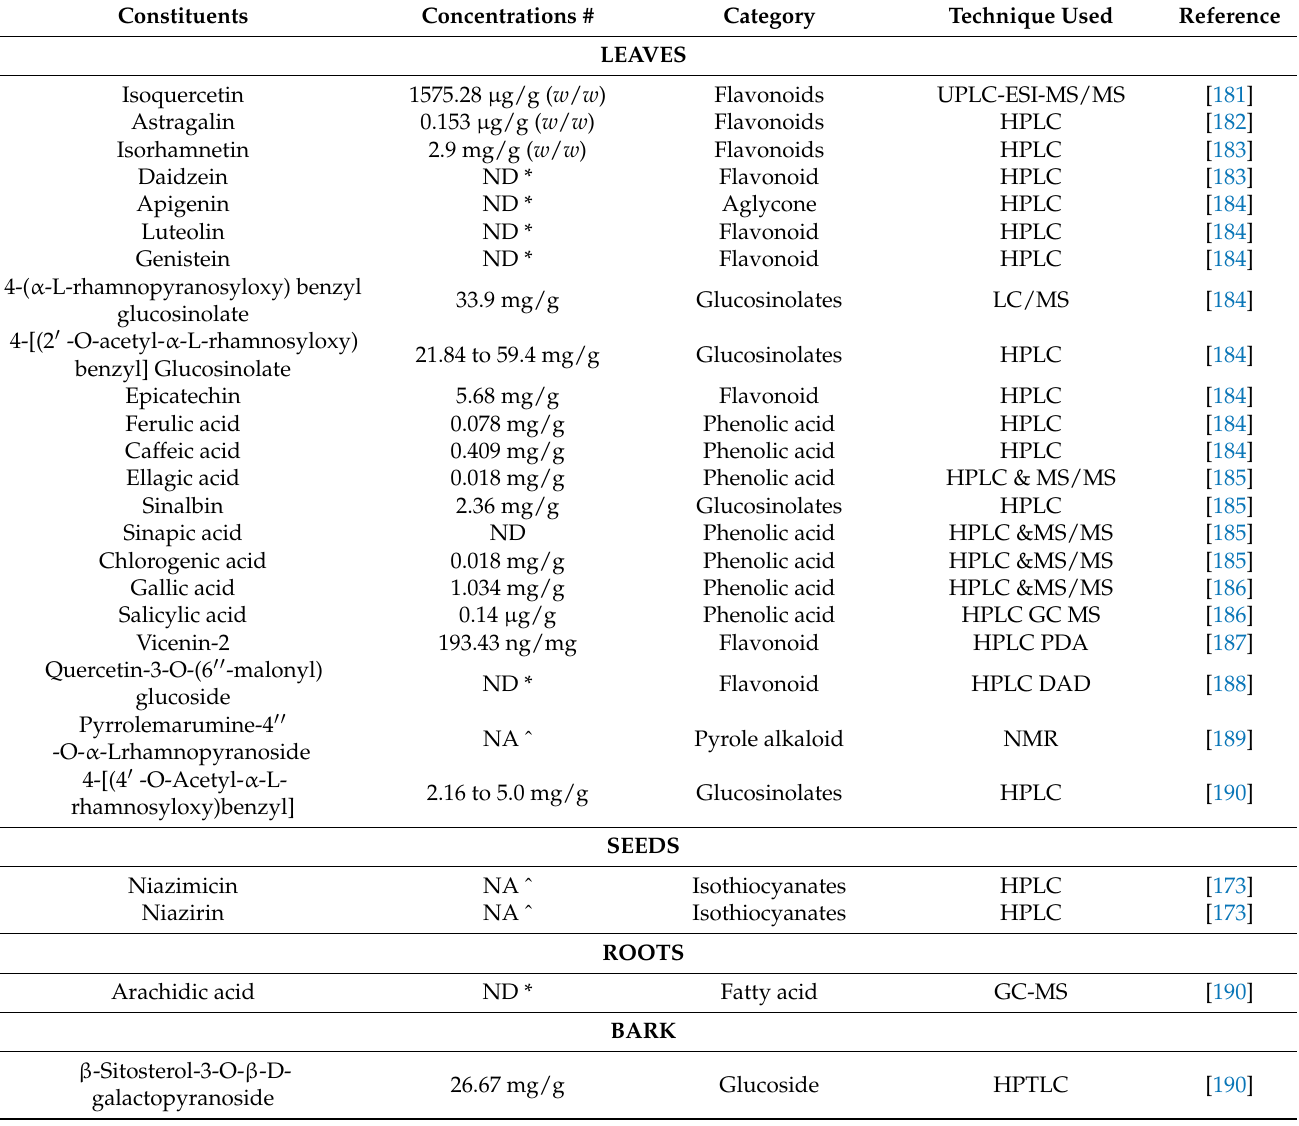
Table 5. Select phytoconstituents of M. oleifera isolated through various